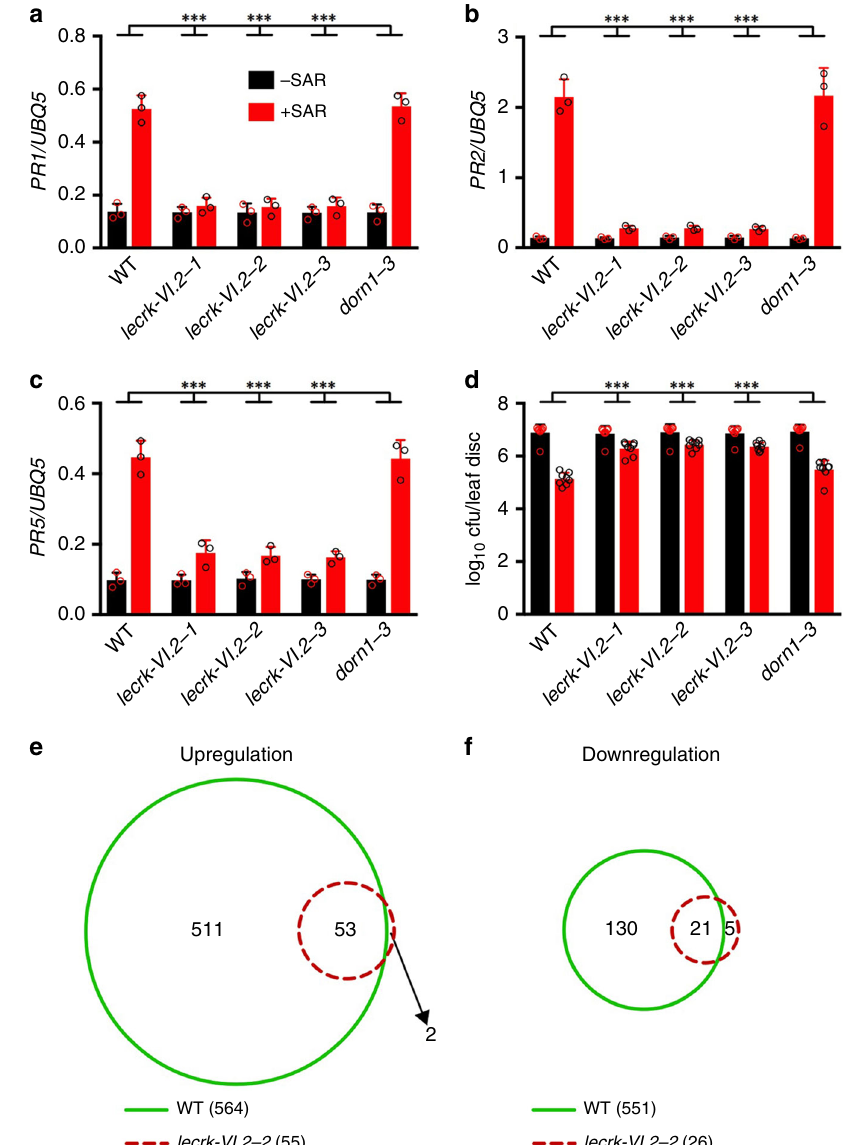
Fig. 4 Biological induction of SAR in the lecrk-VI.2 mutants. a – c Expression of PR1 a , PR2 b , and PR5 c in the systemic leaves of the wild-type (WT), lecrk- VI.2 , and dorn1-3 plants with or without SAR induction. Three lower leaves on each 4-week-old soil-grown plant were in fi ltrated with 10 m M MgCl suspension (OD 600 = 0.002). Two d later, systemic leaves were collected for PR gene expression analysis by qPCR. Expression levels were normalized against the constitutively expressed UBQ5 . Data represent the mean ± SD of three biological replicates. Asterisks denote signi fi cant differences between the induction in the mutants and that in the wild type (*** p < 0.001; two-way ANOVA with Sidak ’ s test). d Biological induction of SAR in the wild-type, lecrk-VI.2 , and dorn1-3 plants. Three lower leaves on each 4-week-old soil-grown plant were in fi ltrated with 10 m M MgCl 0.002). Two d later, two systemic leaves were challenge-inoculated with Psm (OD 600 = 0.001). Three d later, eight leaves were collected to examine the growth of the pathogen. Data represent the mean ± SD of eight biological replicates. Asterisks denote signi fi cant differences between the induction in the mutants and that in the wild type (*** p < 0.001; two-way ANOVA with Sidak ’ s test). e , f Overlaps between the genes that were up- e or downregulated f in the systemic leaves of the wild-type and lecrk-VI.2-2 plants. Plants were treated as in a – c . Total RNA extracted from the systemic tissues was subjected to microarray analysis. Genes with an absolute fold change ≥ 2 and a q value ≤ 0.05 were compared with obtain overlapped genes among the wild-type and lecrk-VI.2-2